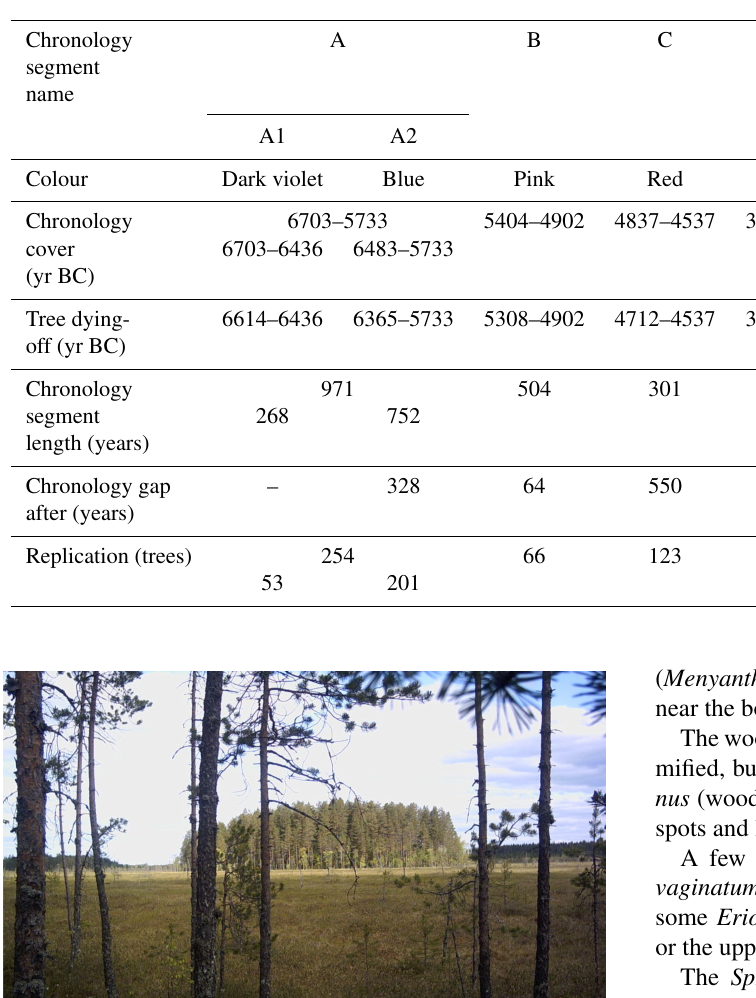
Table 1. Chronology cover. For this table, only the measured rings were used, and estimations of missing rings to pith or bark were not added. Only the trees with dendrochronological calendar dates are listed below.